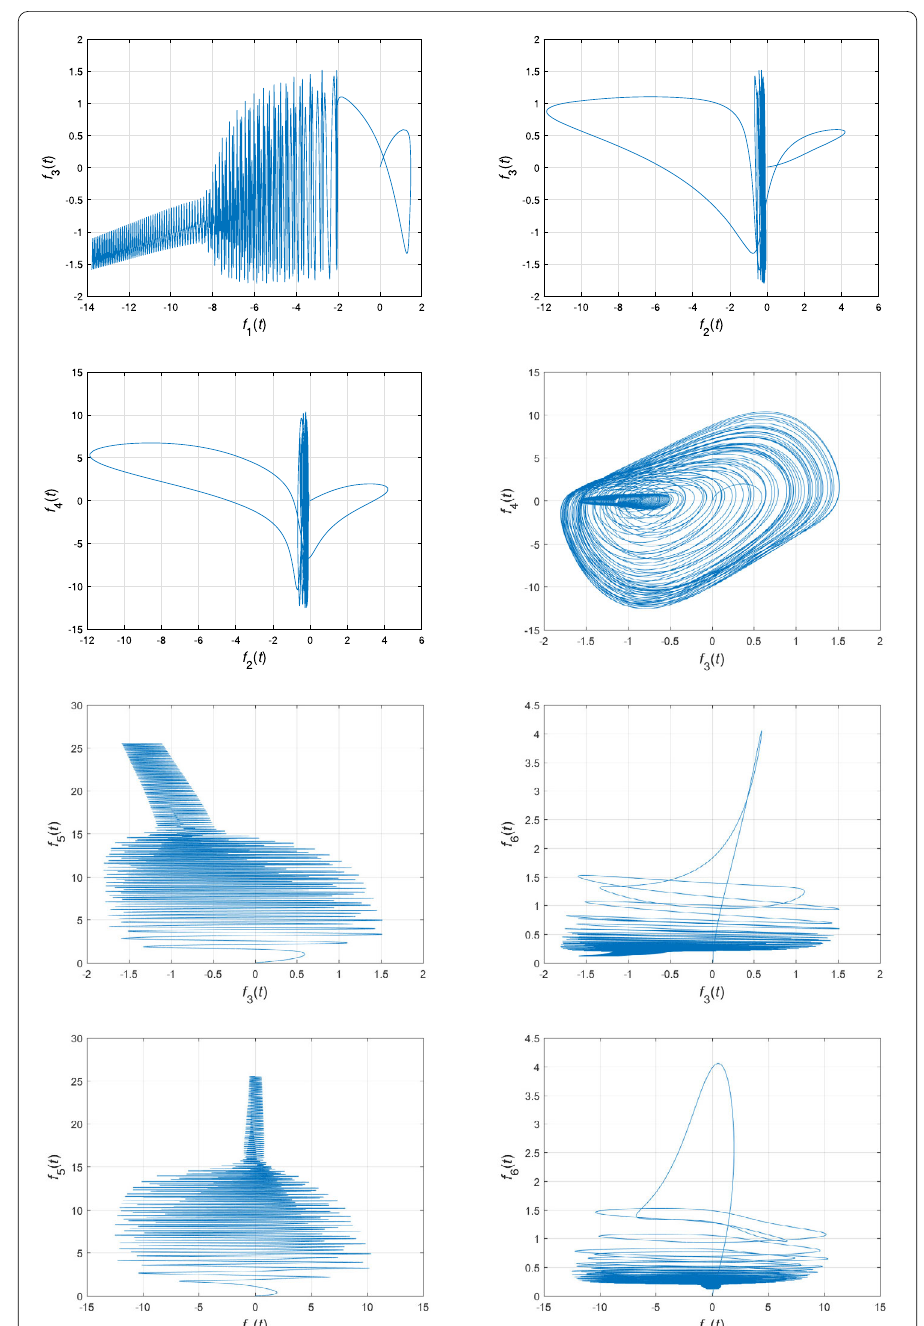
Figure 3 Two-dimensional phase planes of the fractional cardiac conduction model (10) for q i =